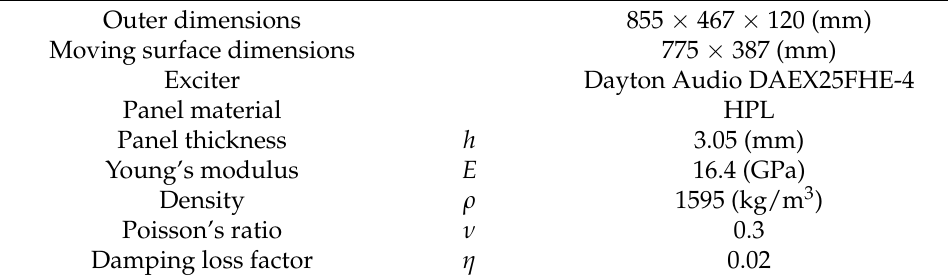
Table 1. Overview of the prototype dimensions and panel properties.